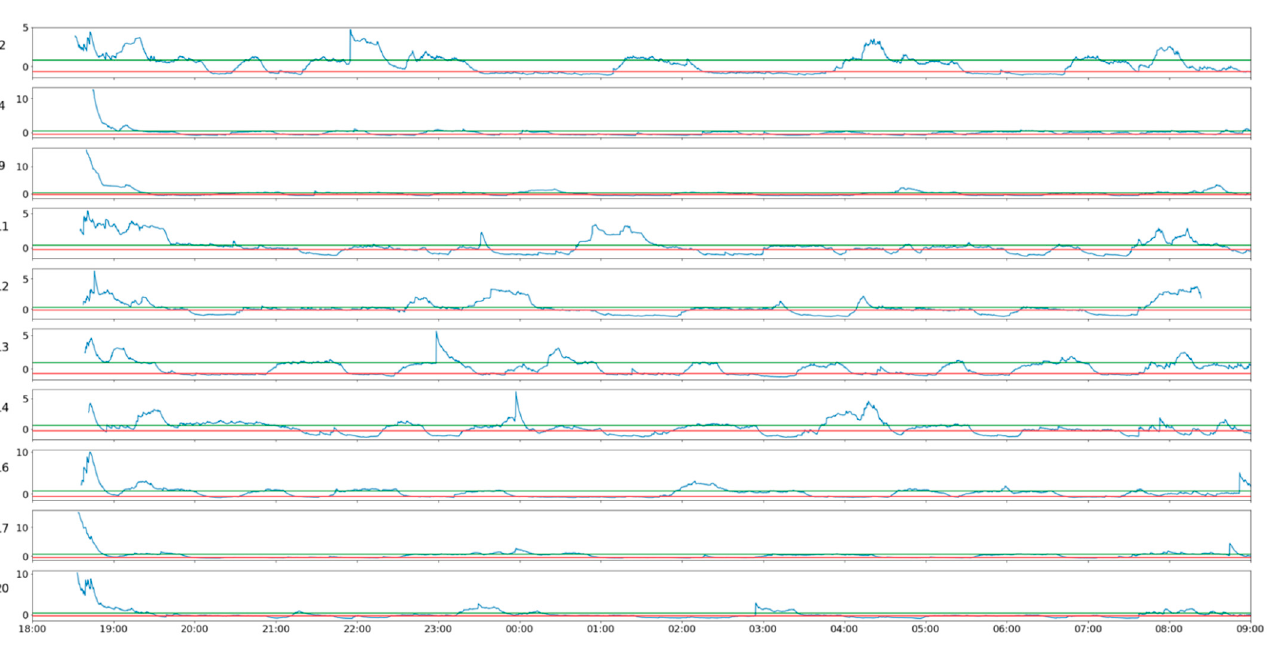
Figure 3. Flock DBA evolution between 18:00 05/12 and 9:00 06/12. The green and red lines represent the 0.8 and 0.4 percentiles, respectively.